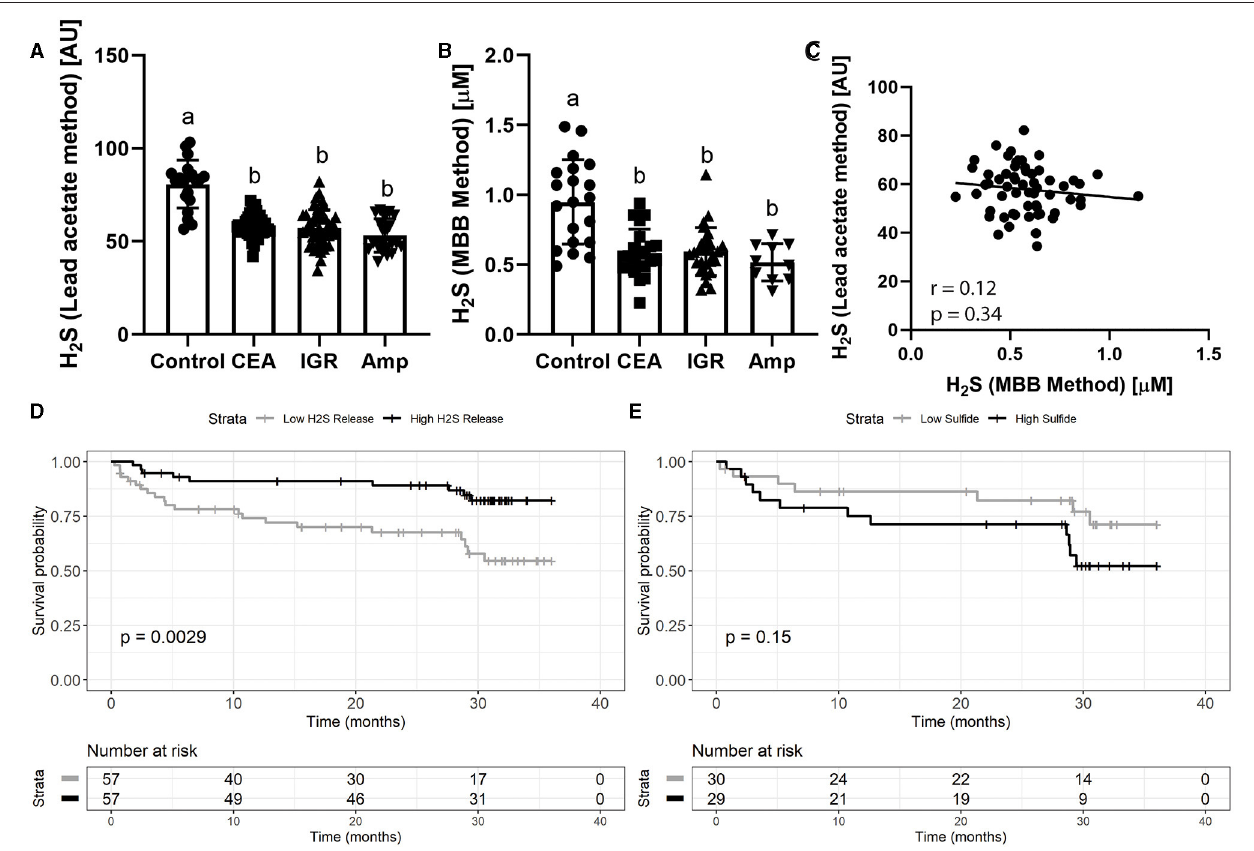
FIGURE 1 | Plasma H 2 S production capacity and sulfide levels are reduced in patients with vascular disease, with production capacity predicting mortality. (A) Plasma H2S production capacity and (B) plasma sulfide measured by the MBB method from human patients suffering vascular occlusive disease including 115 patients undergoing carotid endarterectomy (CEA), infra-inguinal revascularization (IGR) and amputation (Amp), as well as age-matched individuals ( n = 20). Error bars indicate SD; different letters indicate difference p < 0.05 in One Way ANOVA Tukey post-hoc test. (C) Correlation between H 2 S production capacity and sulfide measured by the MBB method in vascular disease patients. (D) Probability of survival for vascular disease patients during follow up after intervention with low ( n = 57) vs. high ( n = 57) H 2 S production capacity and (E) low and high plasma sulfide measurements. High vs. low was determined by median split. P value calculated from log-rank